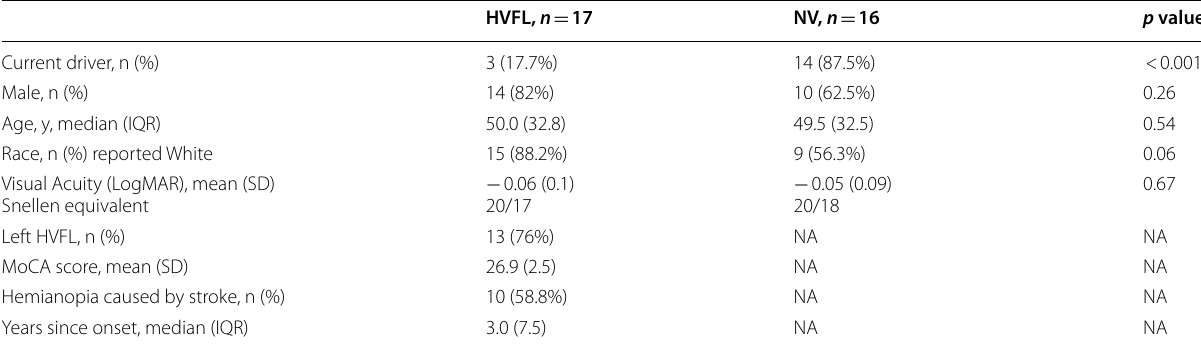
Table 1 Demographic information for those with homonymous visual field loss (HVFL) and normal vision (NV)